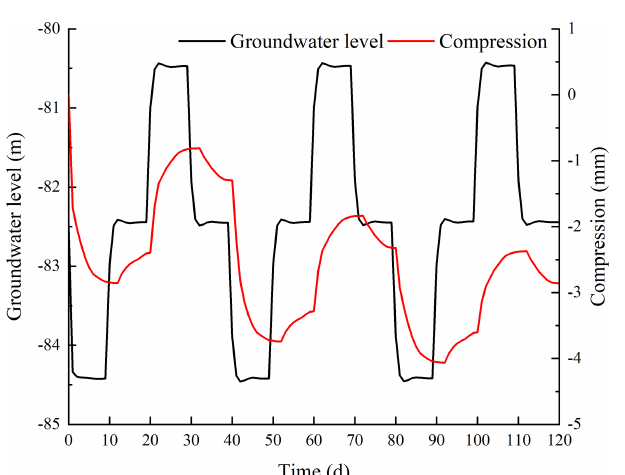
Figure 2. Compressed volume and water level with stress period in the third confined aquifer group under the first pumping and recharge scheme.